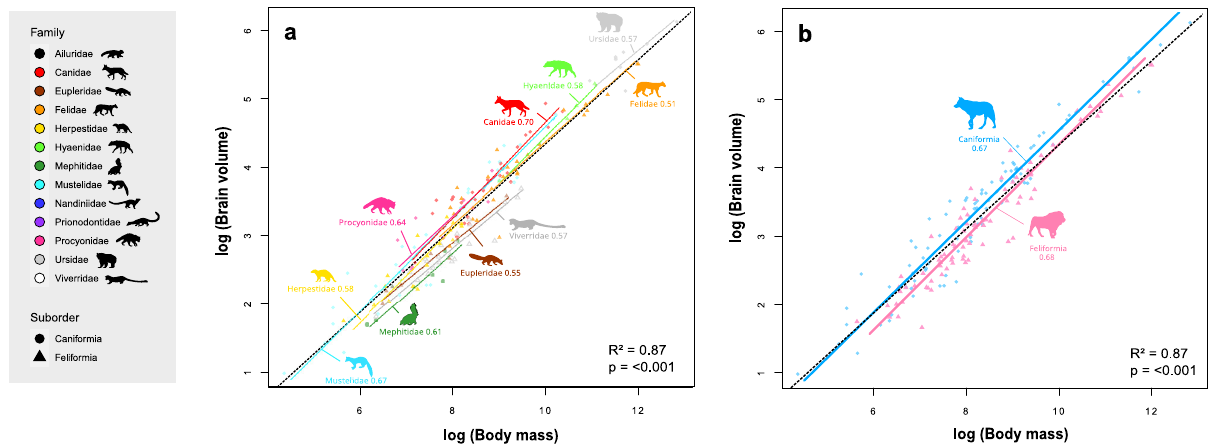
Fig. 1 Encephalization slopes estimated for carnivoran taxonomic groups. Slopes were estimated for a carnivoran families and b the two suborders. Values on the allometries of encephalization indicate slope characterizing the encephalization for each taxonomic group. Black doted slope represents the correlation between brain volume and body mass in terrestrial carnivorans using a phylogenetic generalized least squares regression on dataset 1 (N = 174), with R2 and p-values associated.